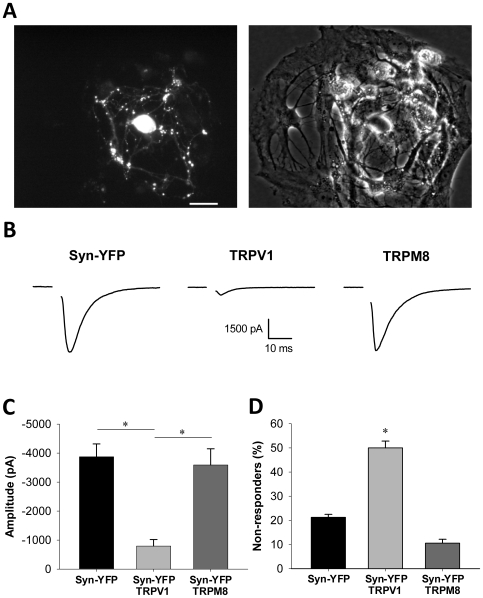
TRPV1 transfection, but not TRPM8 transfection, alters synaptic transmission.(A) Fluorescence (left panel) and phase contrast (right panel) images of a single-neuron (autaptic) island in microisland culture transfected with synaptophysin-YFP (Syn-YFP). Scale bar denotes 50 µM. (B) Representative examples of excitatory postsynaptic currents (EPSCs) evoked in transfected autaptic neurons 1 day after transfection. Stimulus artifact has been blanked in each trace for clarity. Note that TRPV1-transfected neurons produced EPSCs with smaller amplitudes than TRPM8-transfected neurons or Syn-YFP-transfected controls. (C) Quantification of average PSC amplitudes for transfected autaptic neurons. Error bars represent SEM. TRPV1-transfected neurons produced significantly smaller evoked PSCs than Syn-YFP-transfected or TRPM8-transfected neurons (ANOVA, p<0.01; Tukey-Kramer method, p<0.01). (D) Percentage of transfected autaptic neurons that did not respond to electrical stimulation with a detectable PSC. When non-responders were analyzed as “failures” from a binomial distribution, the percentage of TRPV1-transfected neurons that successfully responded to stimulation was significantly decreased from YFP-transfected controls (binomial test, p<0.01). Error bars represent SEM based on the binomial distribution.